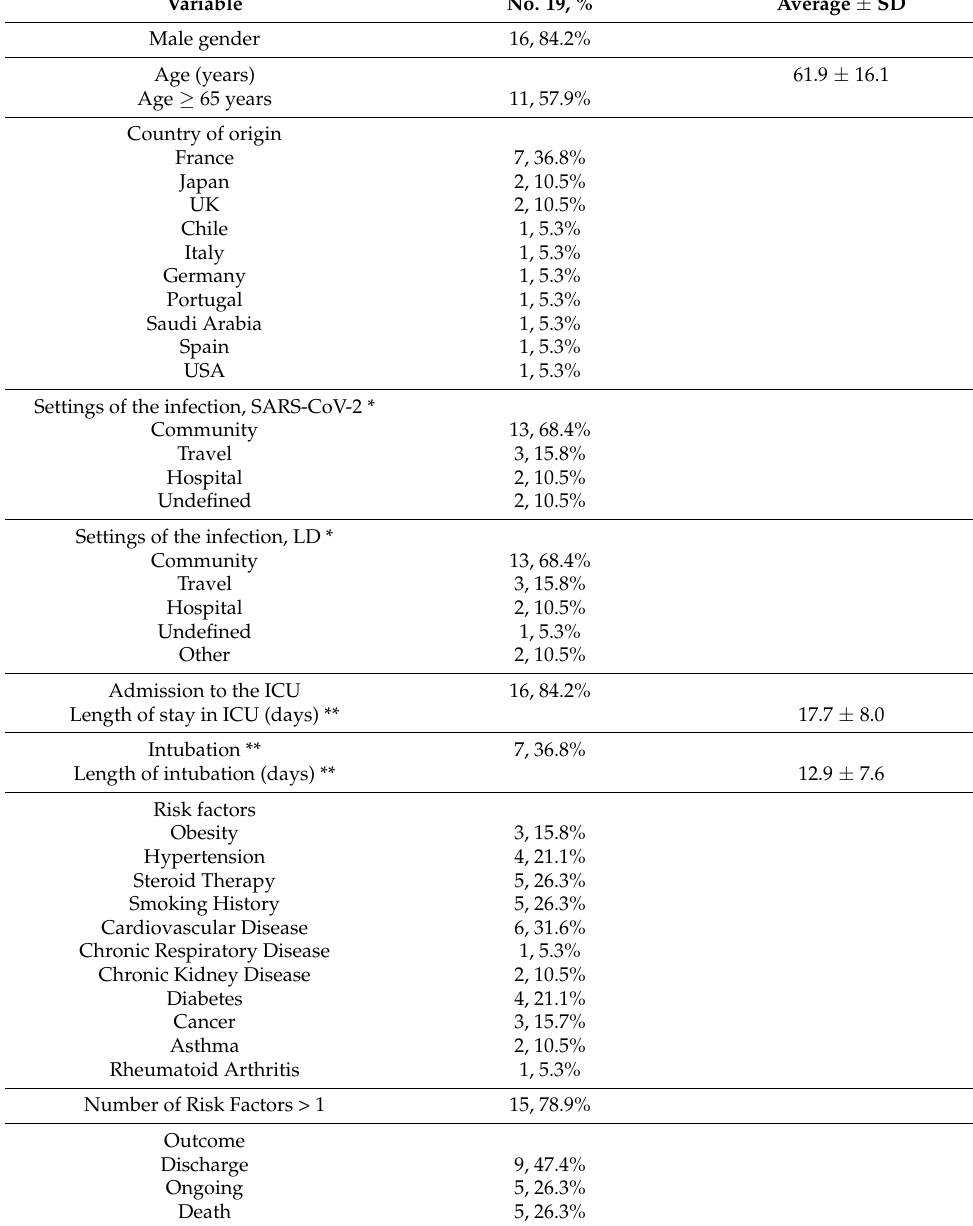
Table 4. Summary of the characteristics of individual cases of SARS-CoV-2 and Legionnaires’ disease